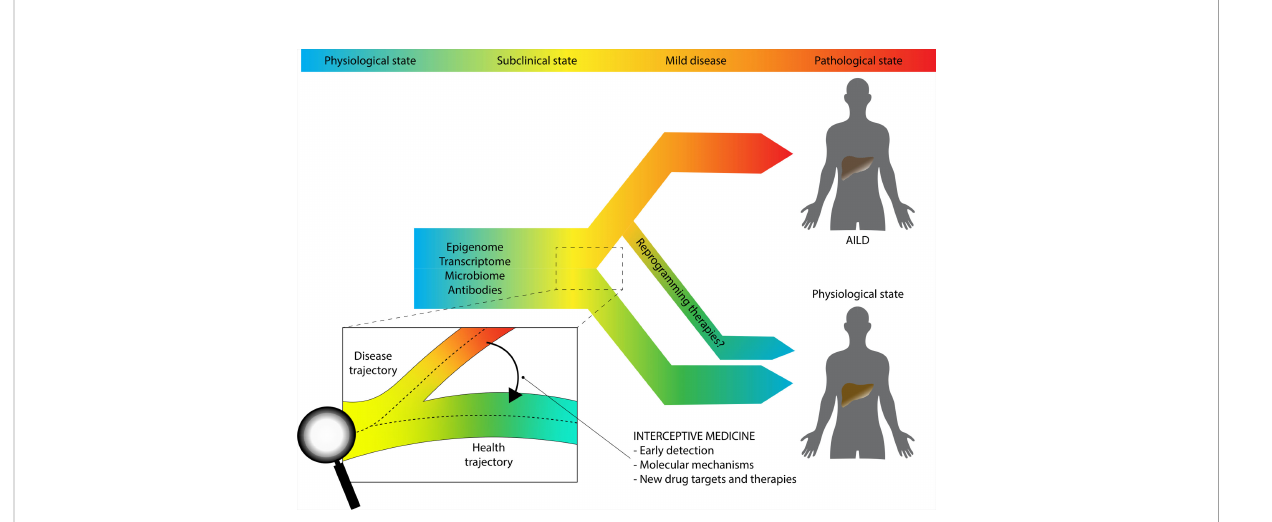
FIGURE 3 Interceptive medicine. The paradigm shift to study complex chronic immune-mediated traits proposed by the LifeTime Initiative and the SYSCID